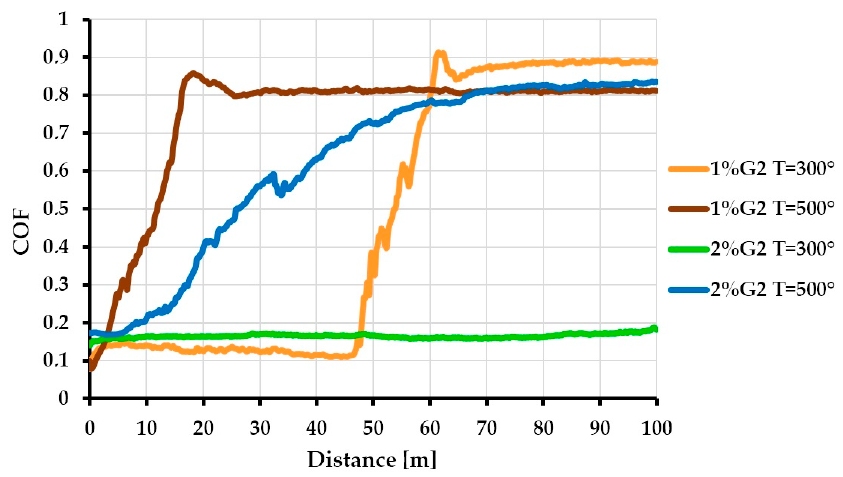
Figure 8. The ball-on-disc test of Al 2 O 3 + G2 graphene coatings heat treated at 300 °C and 500 °C.